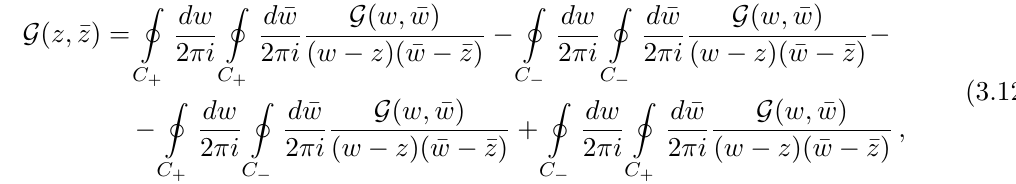
figure 1. The first term on the r.h.s. of (3.12) is holomorphic at ( z, ¯ z ) = (0 , 0) and